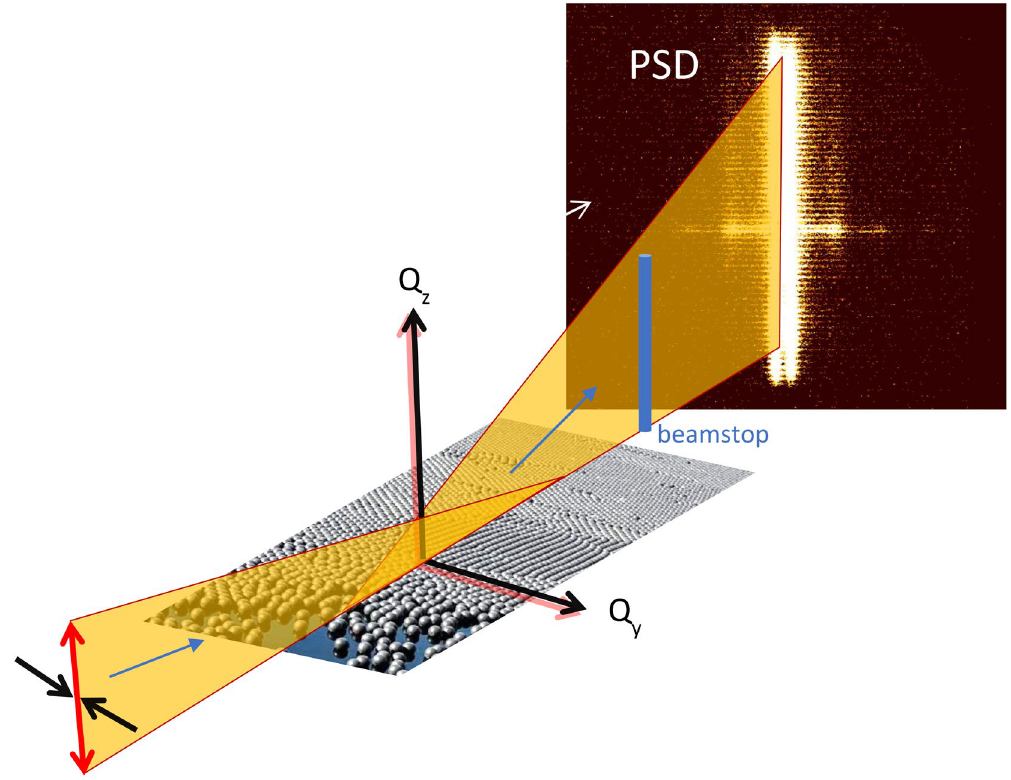
Figure 2. Sketch of the scattering geometry for one-dimensional (π-GISANS)